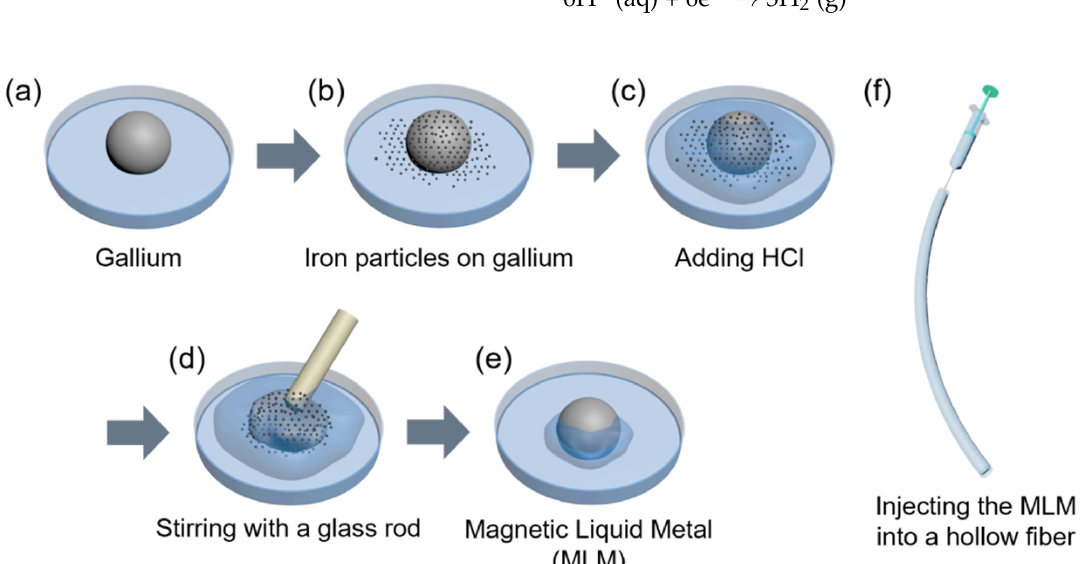
Figure 1. Preparation of the magnetic liquid metal (MLM) and its injection into a hollow fiber. ( a ) Gallium on a petri dish, ( b ) Gallium and iron particles on a petri dish, ( c ) Addition of HCl to immerse gallium and iron particles, ( d ) Stirring the mixture with a glass rod, ( e ) Magnetic liquid metal (MLM), ( f ) Injecting the MLM wire into a core of the hollow fiber.